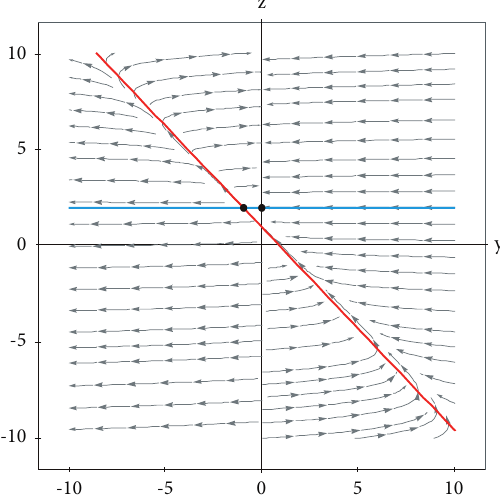
Figure 10: Phase plane of system (9) for ρ / σ < R < 1/ σ , with R ≃ 4 . 678 ( β ′ � 0 . 8 ) ; the other rates are δ � 0 . 071, α � 0 . 1, and σ � 0 . 17. The 0 0 1 vector field and some trajectories are indicated by lines and arrows in gray. Two nullclines are shown: one horizontal (blue line) and other vertical (red line); the horizontal and vertical remaining pair coincides with the z -axis. The disease-free equilibrium point E stable, and the endemic E ∗ ≃ (− 0 . 972 , 1 . 972 ) is an unstable node of two “straight-line” solutions; both points are indicated by a black circle.